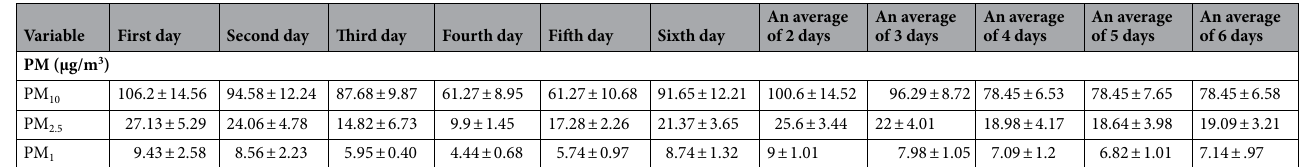
Table 4. The average concentration of exposure to particulate matter measured in a school dormitory in the second sampling period(June-summer).